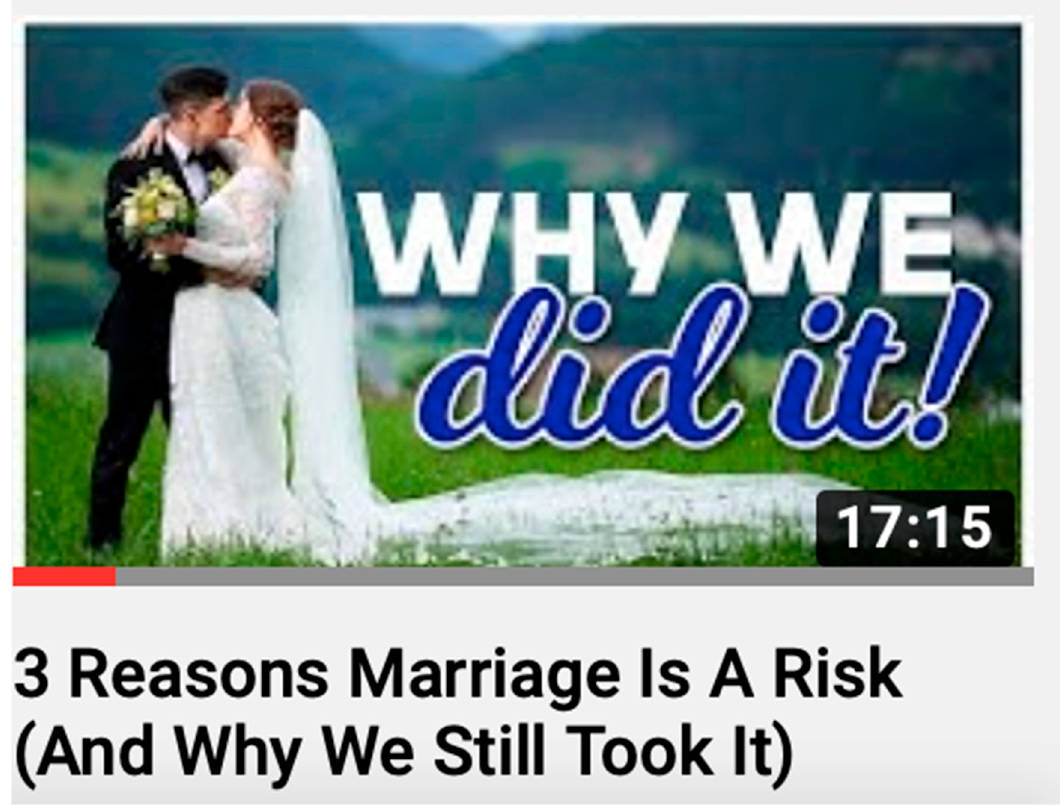
Figure 9. YouTube video on Marriage.